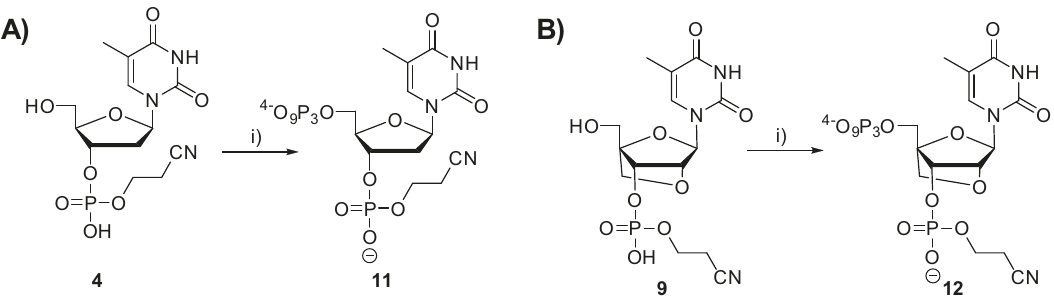
Fig. 6 Synthesis of 3 ′ - β -cyanophosphate-dTTP 11 and 3 ′ - β -cyanophosphate-LNA-TTP 12. A Synthetic scheme for the synthesis of nucleotide 11 and ( B ) synthetic scheme leading to nucleotide 12 . Reagents and conditions: (i) 2-chloro-1,3,2-benzodioxaphosphorin-4-one, pyridine, dioxane, rt, 45 min; 2.